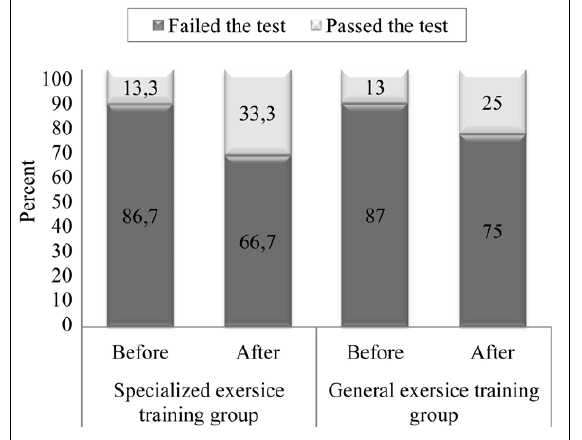
Figure 5. “One leg stance” test